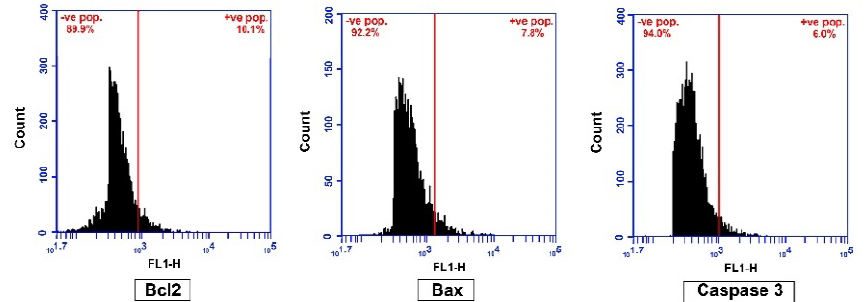
Figure 6. Flow cytometry analysis of negative control cells acquired without stain for Bcl2, Bax and Caspase 3.